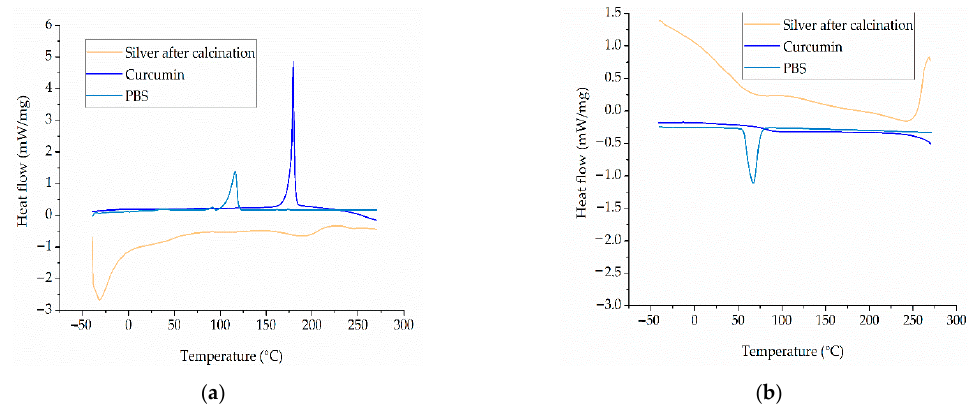
Figure 5. DSC thermograms of PBS, curcumin, and silver. ( a ) Heating cycle. ( b ) Cooling cycle.